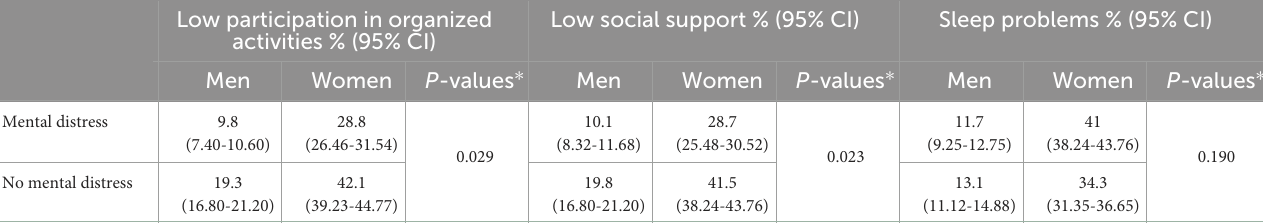
TABLE 2 Differences in mental distress between men and women with low participation in organized activities, low social support and sleep problems. Low participation in organized activities % (95%